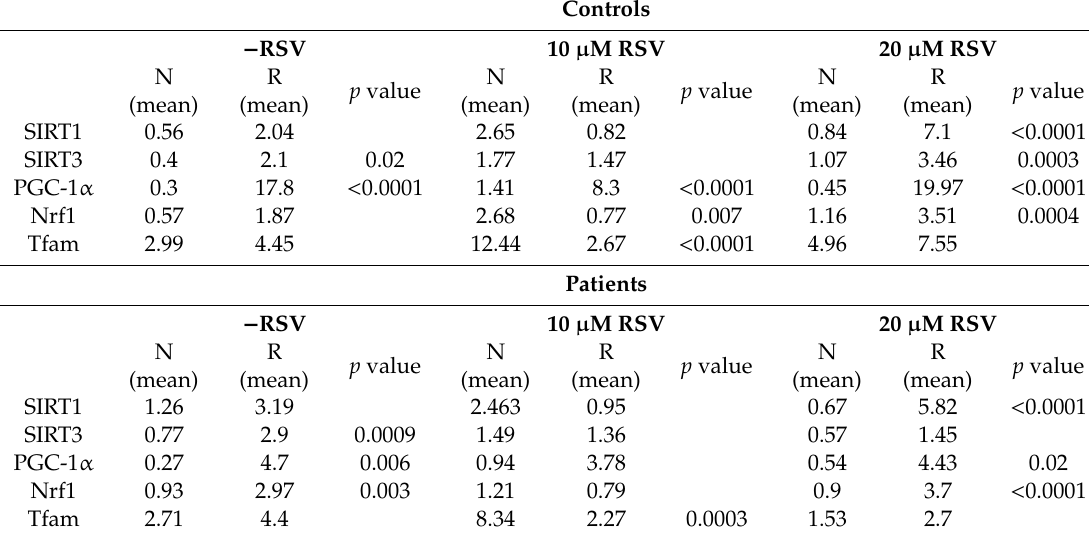
Table 5. Comparison of the relative expression rate of the genes SIRT1 , SIRT3 , PGC-1 α , Nrf1 , and Tfam measured under N or R conditions in patients (n = 5) and controls (n = 5). p values are only shown in the case of significant di ff erences between patients and controls. − RSV = without